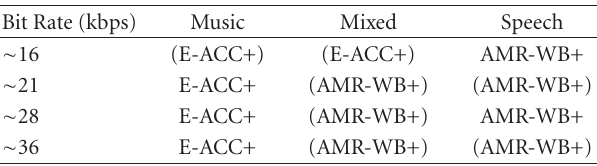
Table 3: Audio codec preference for di ff erent stereo audio content types (Derived from characterization results in 3GPP TR